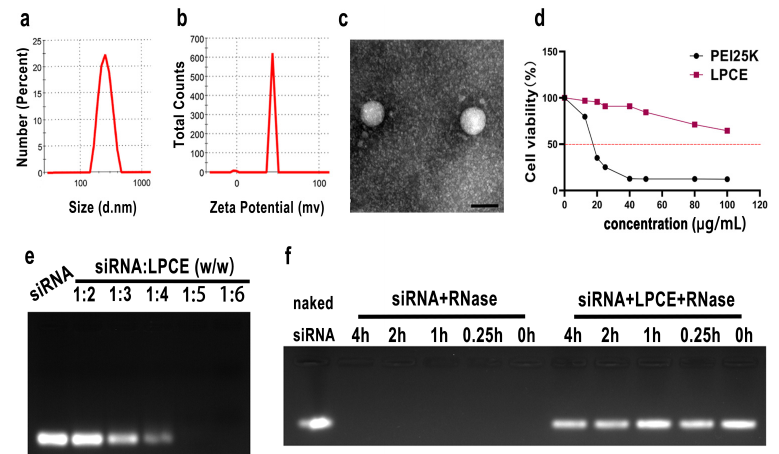
Figure 1. Characterization of LPCE micelle. ( a , b ) Size distribution and zeta potential of the LPCE. ( c ) Transmission electron microscopy photomicrographs of LPCE (scale bar, 200 nm). ( d ) Cell viability assay of LPCE and PEI25K on 293T cells. ( e ) Gel-retarding assay of the LPCE/p65 siRNA complex. ( f ) Ribonuclease protection assay of the LPCE/p65 siRNA complex.